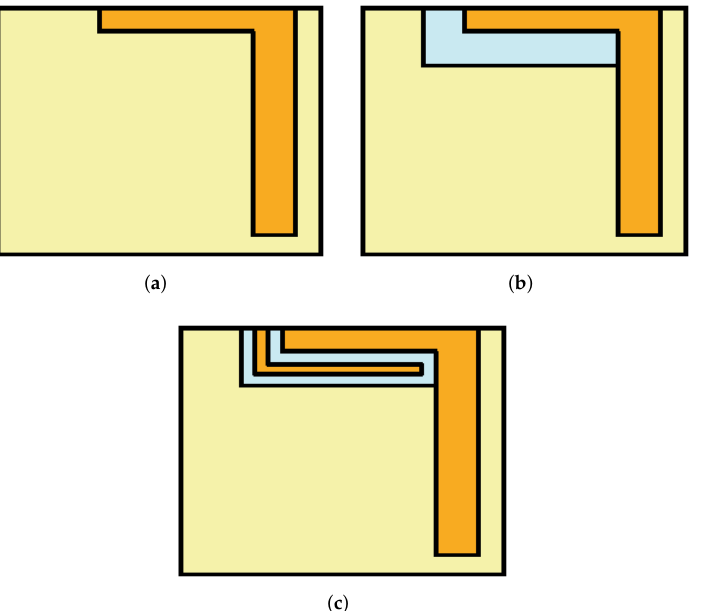
Figure 2. Design steps of single antenna element: ( a ) Step 1, ( b ) Step 2, and ( c ) Step 3. Orange, top metal; light blue, dielectric substrate; and light yellow, bottom metal.